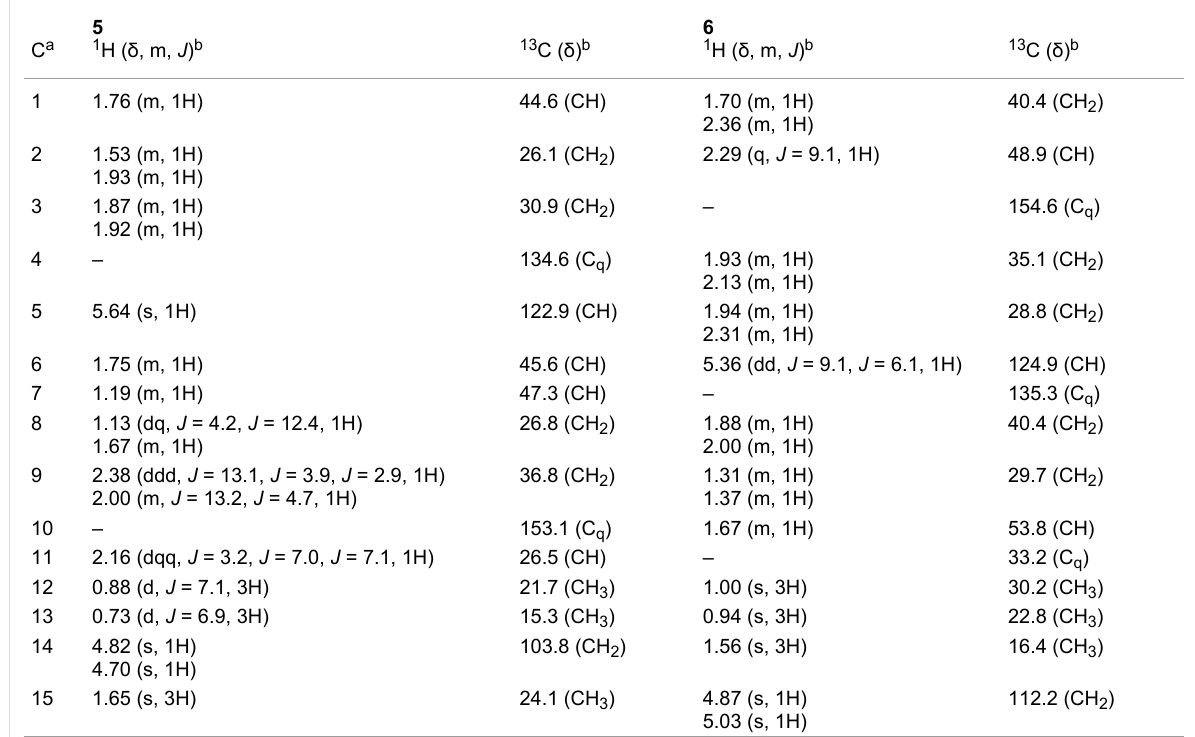
a Carbon numbering as in Figure 1. b Chemical shifts δ in ppm; multiplicities: m = multiplet, s = singlet, d = doublet, sept = septet, br = broad; coupling constants J in